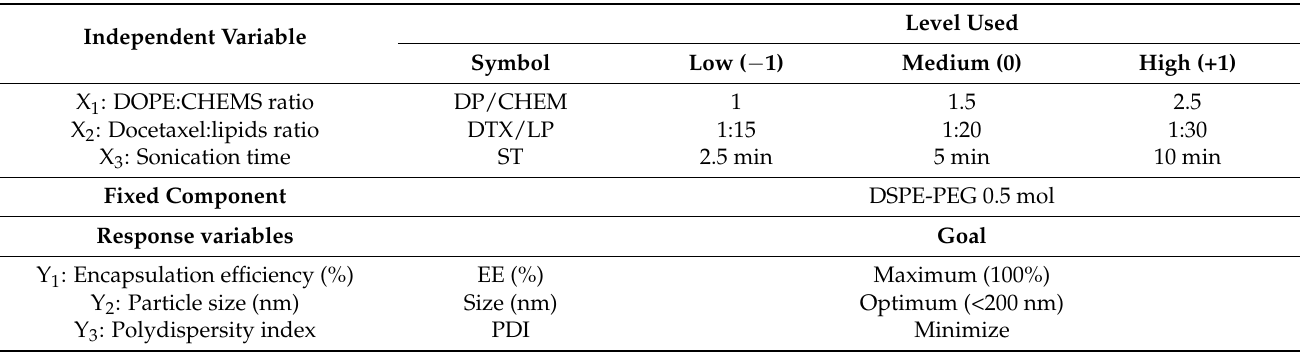
Table 1. Variables in the Box–Behnken